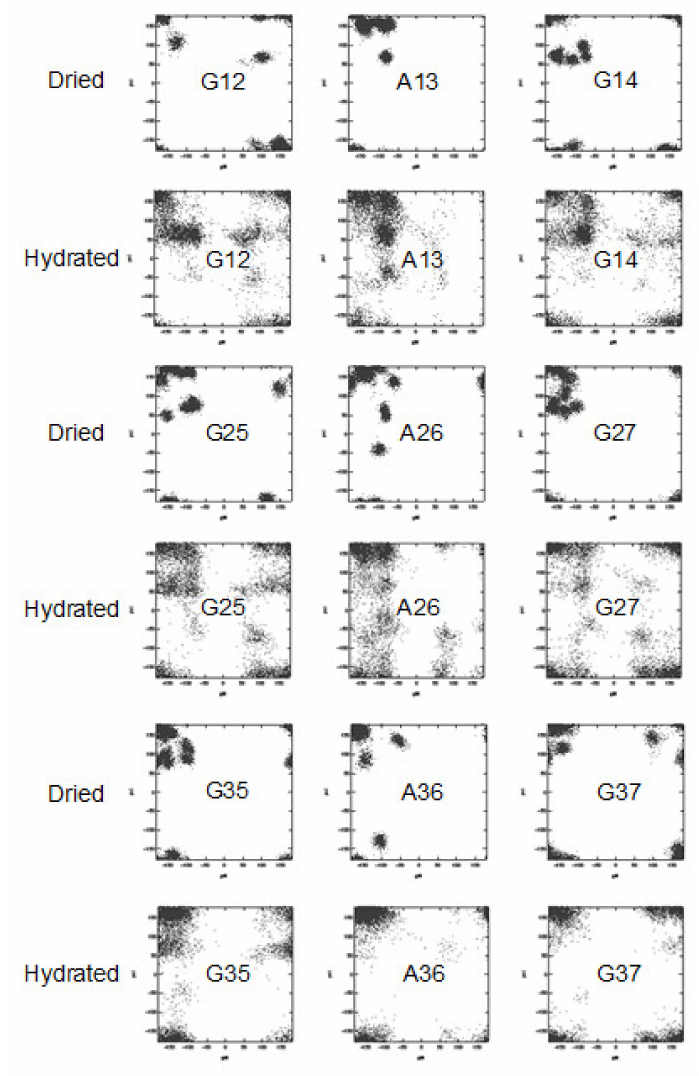
Figure 12. Ramachandran maps showing the distributions of ( Φ , Ψ ) torsion angles of the residues in the motifs, Gly 12 Ala 13 Gly 14 , Gly 25 Ala 26 Gly 27 , and Gly 35 Ala 36 Gly 37 of the Gly-rich region in the dry and hydrated states, respectively, as calculated by MD simulation